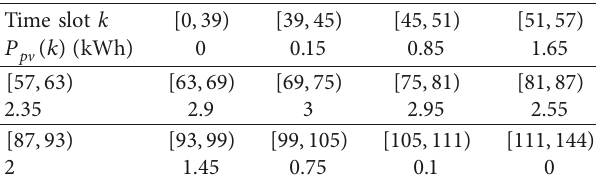
Table 3: Hourly PV